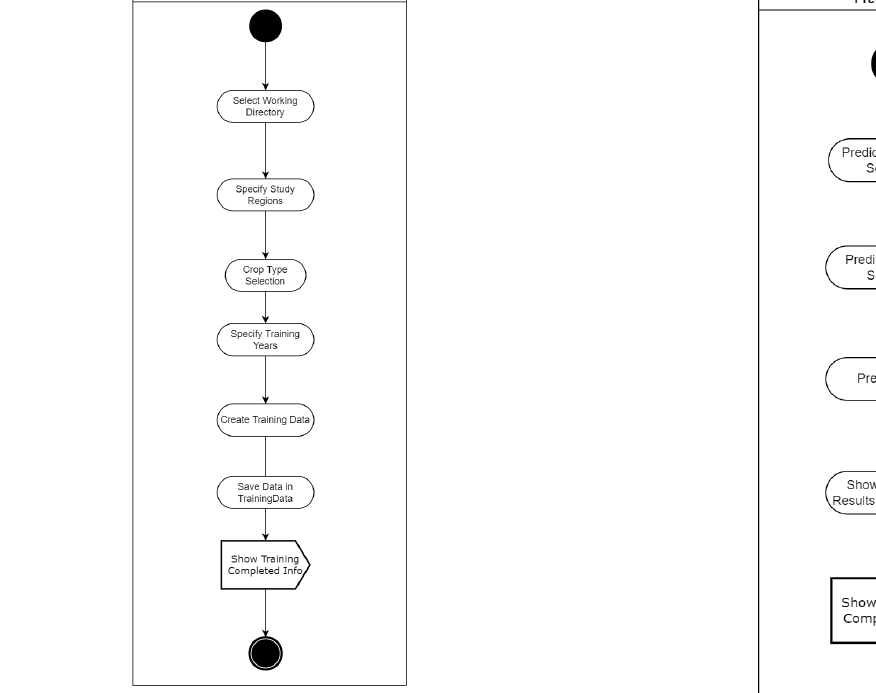
Figure 3. Prepare Training Dataset